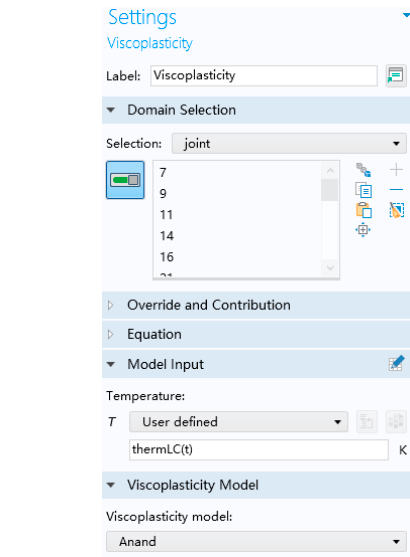
Figure 5. The settings of ( a ) thermal expansion module; ( b ) viscoplasticity module.